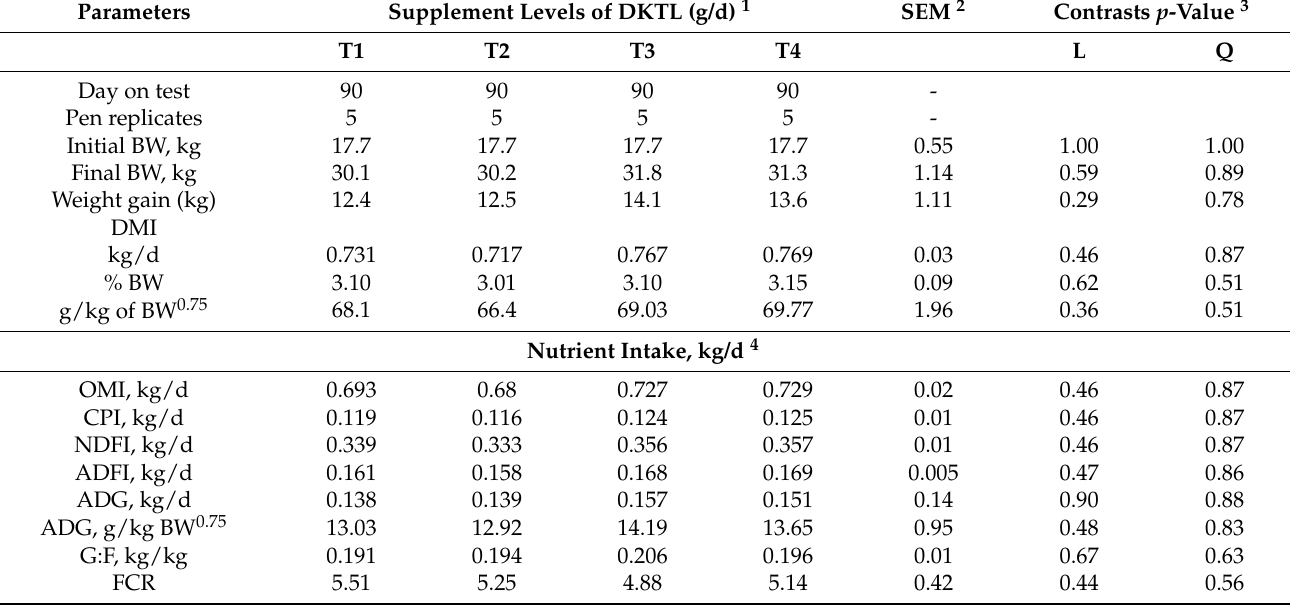
Table 3. Effects of Kratom leaves supplement on feed intake and performance of fattening